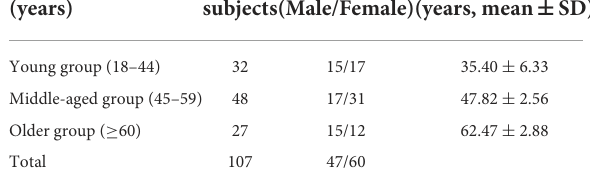
TABLE 1 Demographic data of healthy